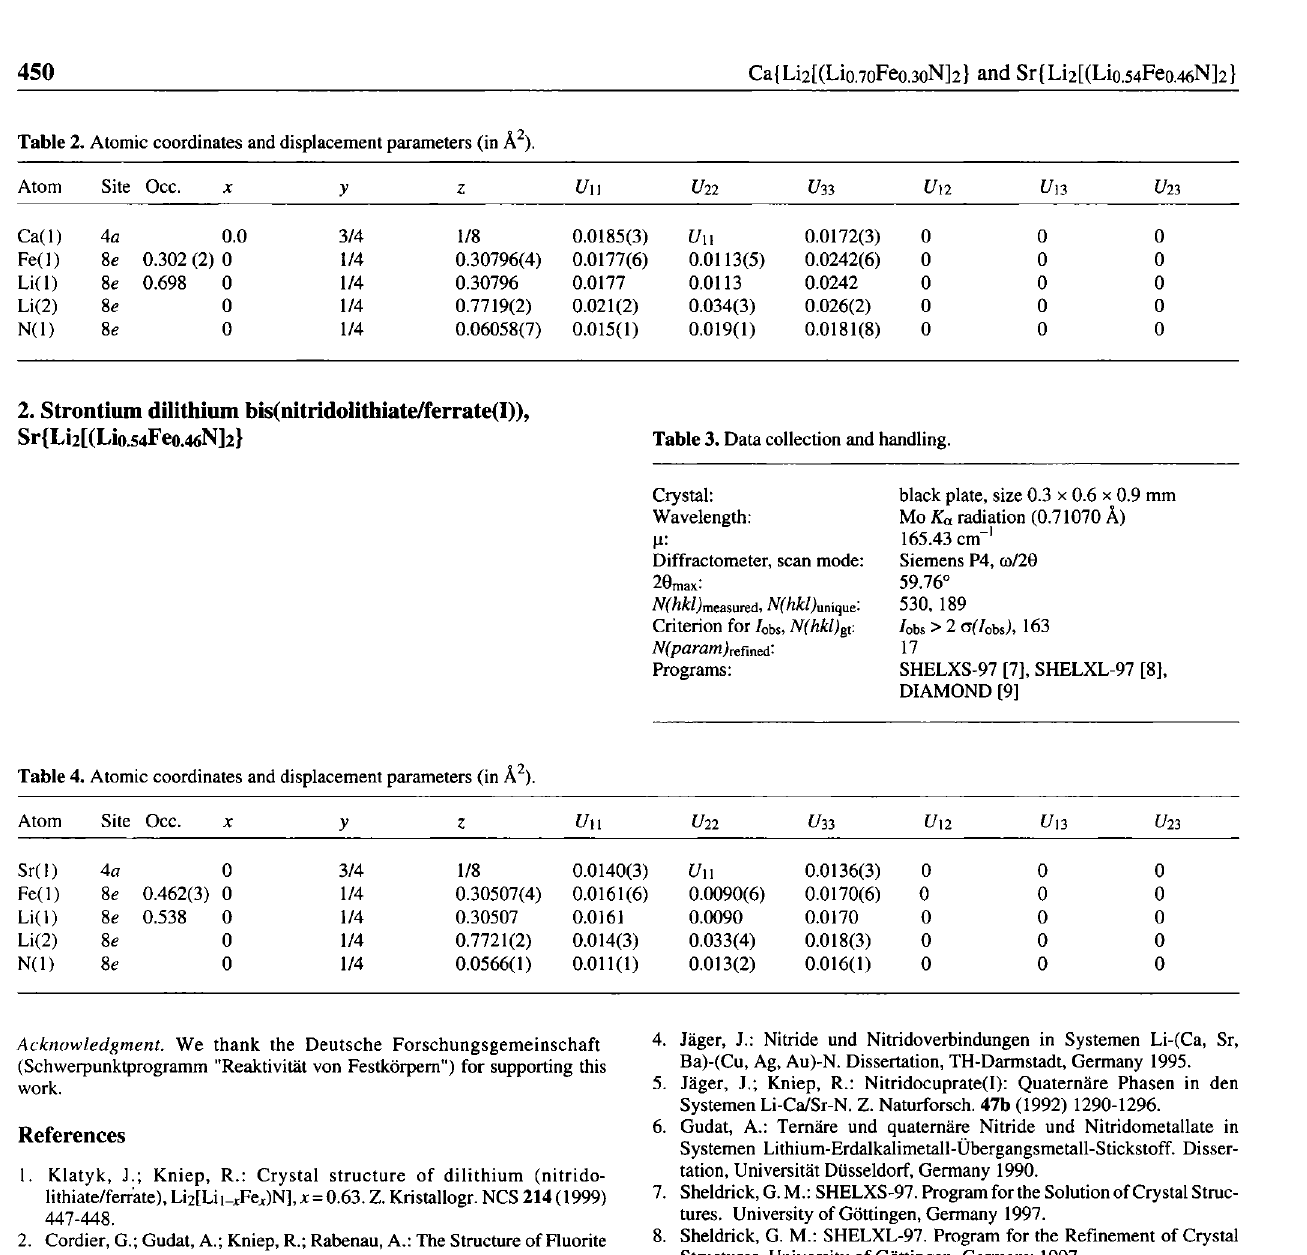
Table 2. Atomic coordinates and displacement parameters (in Ä 2 ). Atom Site Occ.